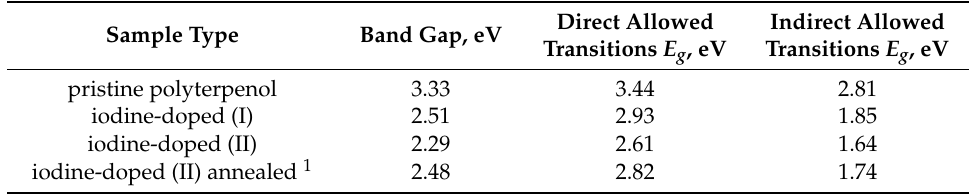
Table 2. Band gap, direct allowed, and indirect allowed transition energy gap of pristine and iodine-doped polyterpenol thin